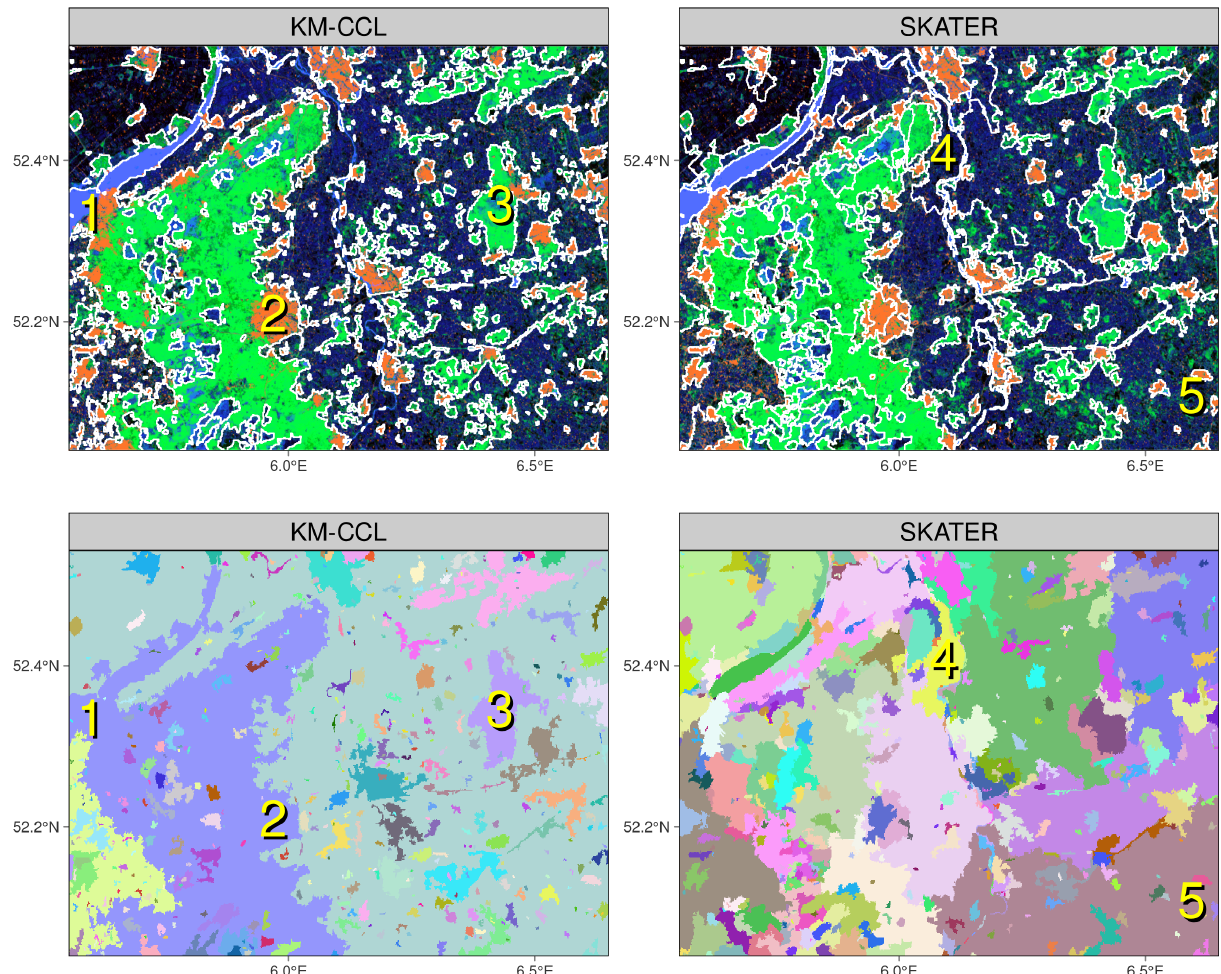
Figure 3. Comparison of the regionalization borders between the KM-CCL approach (left) and the SKATER approach (right) for 468 regions. Yellow numbers highlight areas with different regions between the two regionalizations. Top panels: the white borders of both regionalizations are superimposed on the RGB image created based on the principal component analysis on the input raster with the fractional cover of the eight land cover classes. Bottom panels: random colors represent all of the obtained regions. More explanation about the base map and the yellow numbers can be found in the